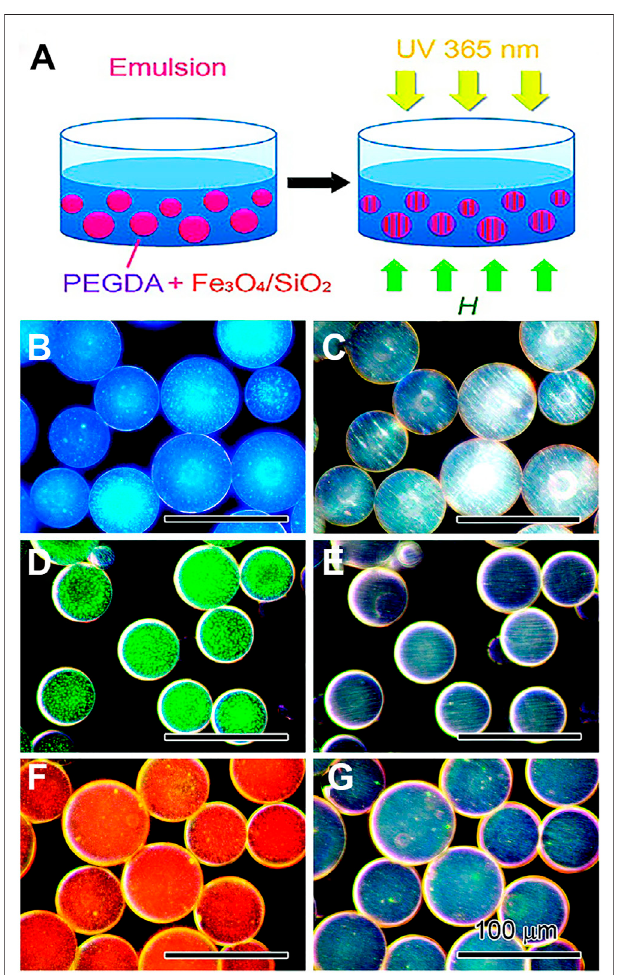
FIGURE 8 | (A) Synthetic procedures for the magnetochromatic microspheres. When dispersed as emulsion droplets, superparamagnetic Fe 3 O 4 @SiO 2 core/shell particles self-organize under the balanced interaction of repulsive and attractive forces to form one-dimensional chains, each of which contains periodically arranged particles diffracting visible light and displaying fi eld tunable colors. UV initiated polymerization of the oligomers in emulsion droplets fi xes the periodic structures inside the microspheres and retains the diffraction property; (B – G) Optical microscopy images (500×) of magnetochromatic microspheres with diffractions switched between “ on ” (B , D , F) and “ off ” (C , E , G) states by using EMFs. These microspheres are preparedusing (B , C) 127, (D , E) 154,and (F , G) 197 nmFe 3 O 4 @SiO 2 colloids. Reprinted with permission from Ge et al. (2009). Copyright © 2009 American Chemical Society.